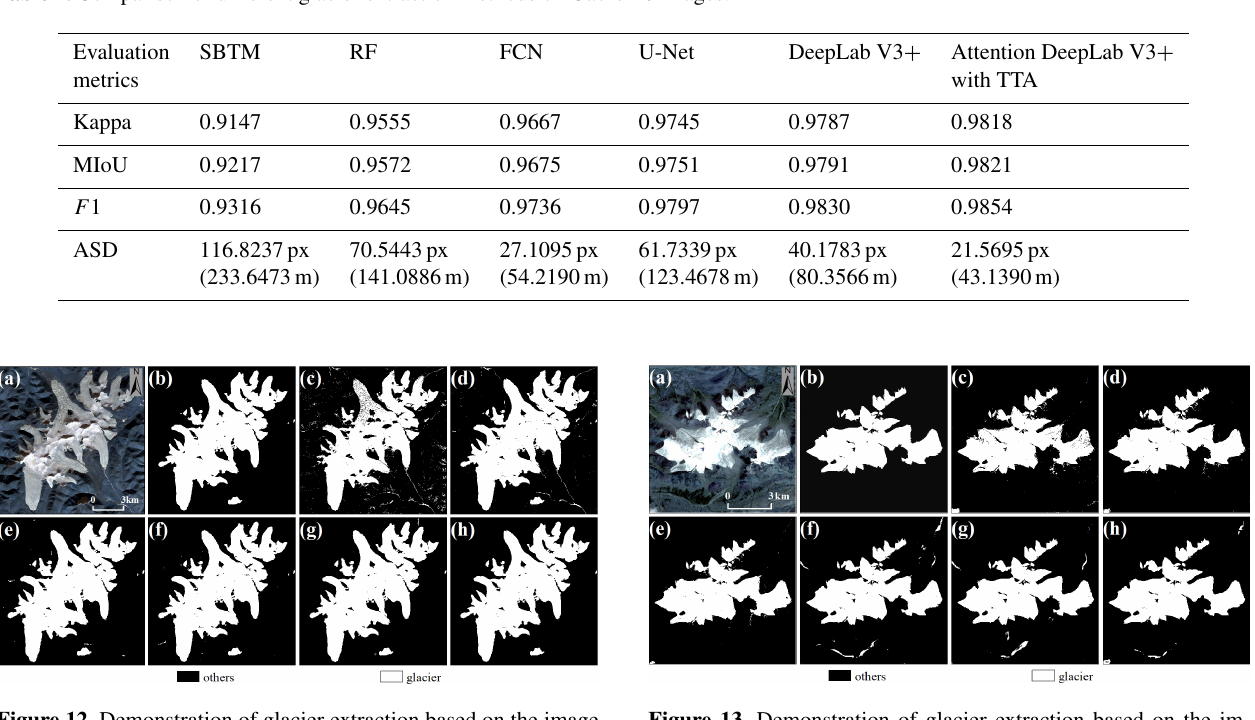
Figure 11. Performance of extraction models by confusion matrix, kappa, MIoU, F 1 and ASD. Table 1. Comparison of different glacier extraction methods on Gaofen-6 images.